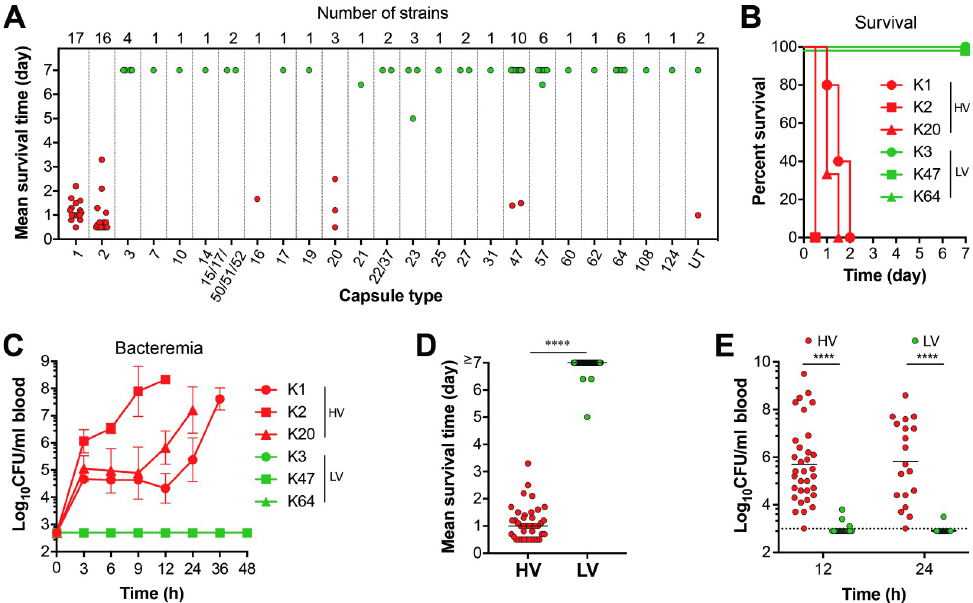
Fig 1. Dramatic variation in the virulence of K . pneumoniae isolates. Virulence levels of K . pneumoniae isolates were assessed in CD1 mice by intraperitoneal (i.p.) infection with 10 6 CFU of each isolate. A. Correlation between capsule type and mean survival time of mice. Mean survival time of mice infected by each high- (HV, red dot) or low-virulent (LV, green dot) isolates in day is presented as a filled circle and grouped in a single column based on capsule type. Capsule type and total isolates tested for each type are indicated at the bottom and top of each group, respectively. UT, untypable. n = 3. B, C. Virulence traits of the HV and LV isolates. Survival rate (B) and bacteremia level (C) of representative HV (K1, K2 and K20) and LV (K3, K47 and K64) strains were determined. Strains are denoted by their capsule types: K1 (TH9885), K2 (ATCC43816), K3 (ATCC13883), K20 (TH12908), K47 (TH12846) and K64 (ATCC35657). n = 5–6. The mice died immediately after bleeding at 12 h in (C) were considered as being survived at this time point. The data were pooled from two independent experiments and presented as mean value ± standard deviation (SD). D, E. Mean survival time (D) and bacteremia level (E) of the mice at 12 and 24 hr post infection with HV and LV strains. n = 3. Each dot represents the mean value of three mice infected with a single strain. Dash line indicates the detection limit. Unpaired t test (D) and two- way ANOVA with Sidak’s multiple comparisons test (E) were performed. ���� , P <